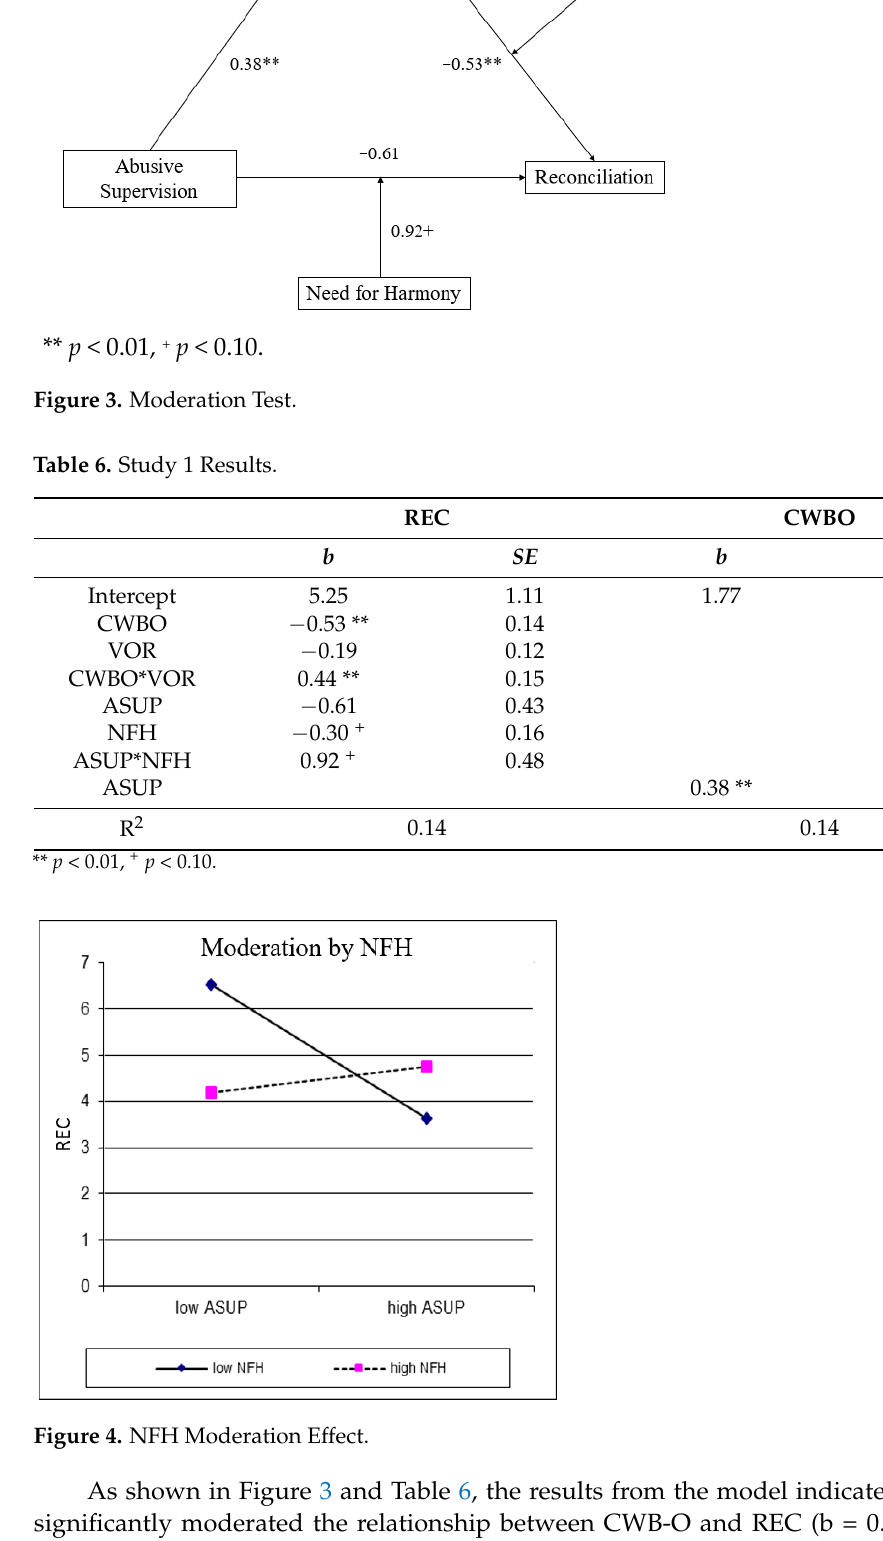
9 Table 5. Study 1 Indirect Effect, Direct Effect, and Total Effect. Effect Size